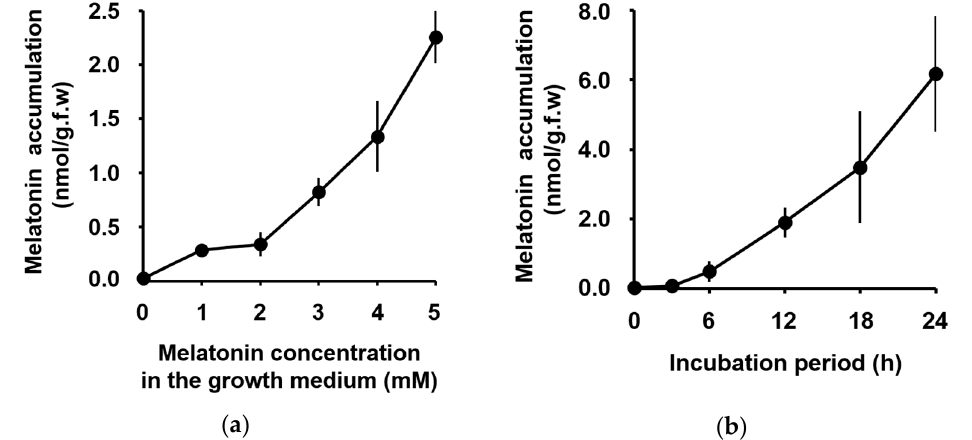
Figure 1. Foliar accumulation of melatonin applied to the roots of maize seedlings. ( a ) Correlation between melatonin accumulation in maize leaves and concentration of melatonin supplied in the growth medium. Melatonin accumulation was measured after 12 h from the melatonin application. ( b ) Time-dependent melatonin accumulation was measured after 4 mM melatonin was supplied. Data represent the mean ± standard deviation (SD) of six ( a ) and three ( b ) biological replicates. Each measurement was carried out with five seedlings.